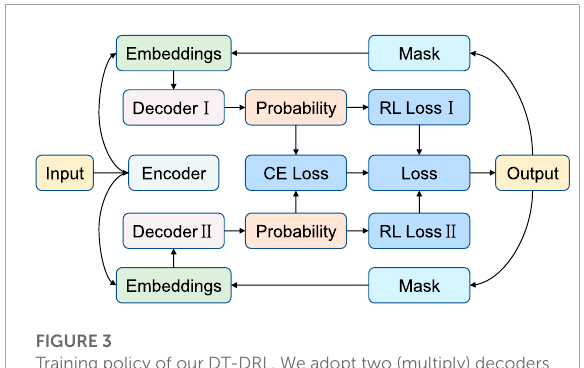
FIGURE 3 Training policy of our DT-DRL. We adopt two (multiply) decoders for